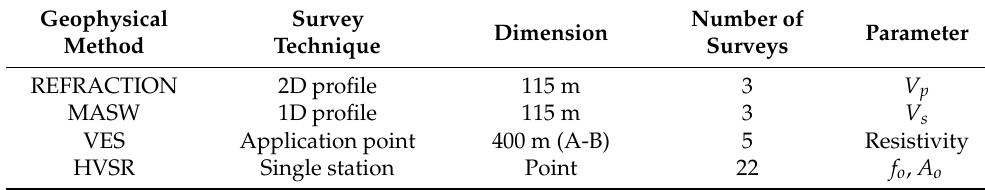
Table 1. Resume of applied geophysical techniques and